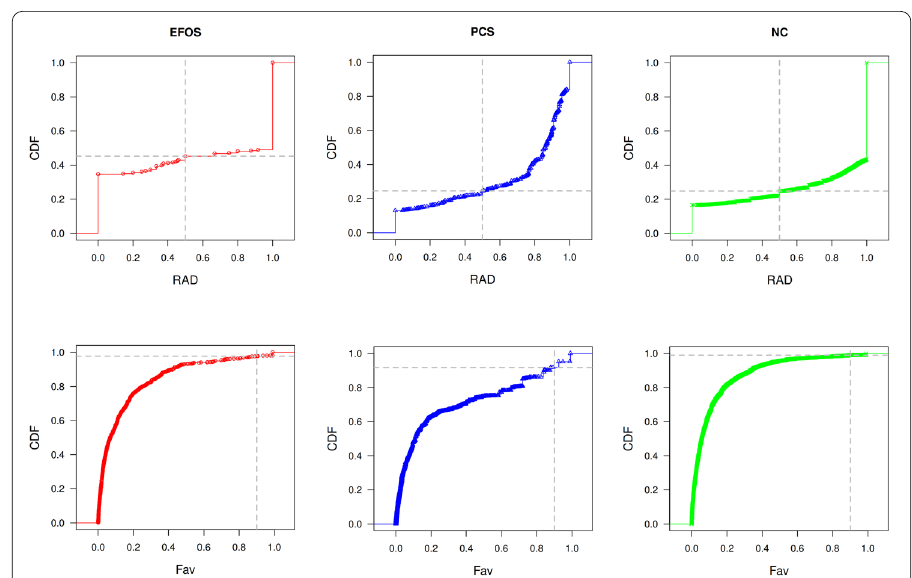
Figure 5 First experiment. CDF for RAD and Fav variables ( Up and Bottom , respectively) for the three different classes EFOS ( Left ), PCS ( Center ), and NC ( Right ). The dashed grey lines indicate the threshold for each risk factor and the value of the CDF in which it was crossed. This value in the CDF indicates the probability to find a contract with the risk factor above the marked threshold given that the contract belongs to the corresponding